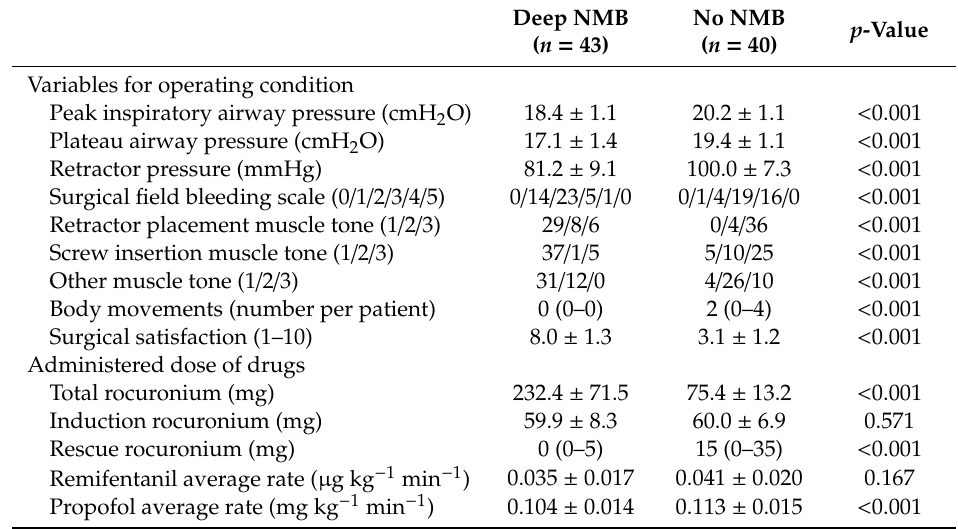
Table 2. Intraoperative outcomes including airway pressures and variables measured for operating condition assessment, and cumulative dose of rocuronium and average infusion rate of anesthetics.